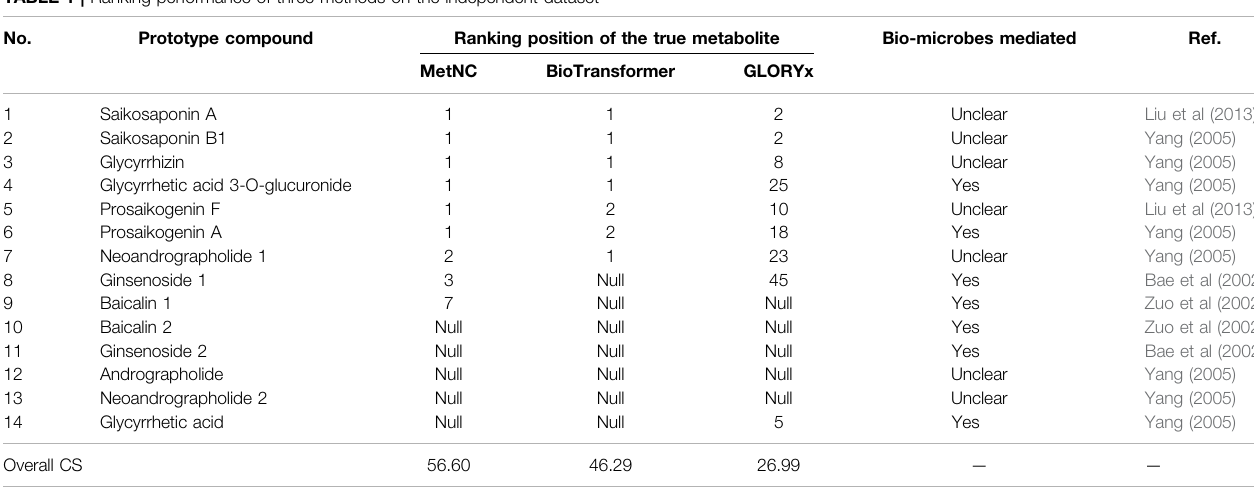
TABLE 1 | Ranking performance of three methods on the independent dataset No. Prototype compound Ranking position of the true metabolite Bio-microbes mediated